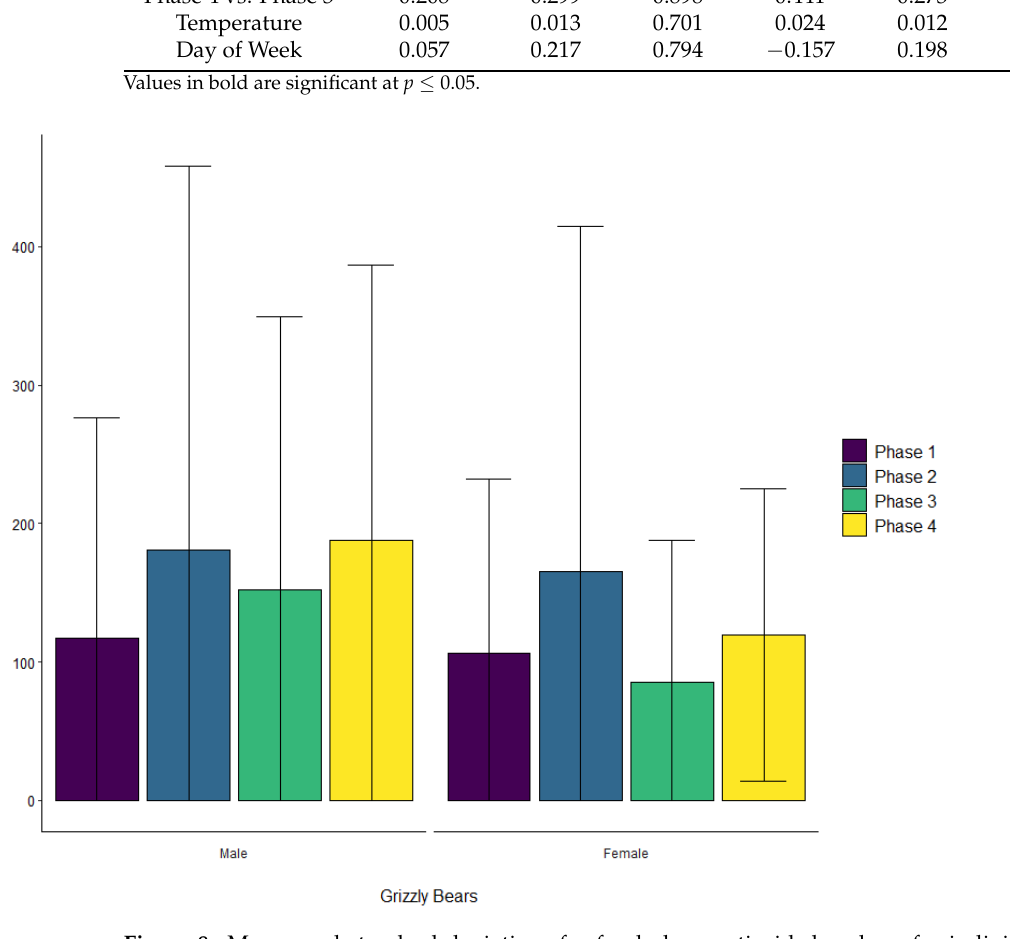
Figure 8. Means and standard deviations for fecal glucocorticoids by phase for individual grizzly bears.